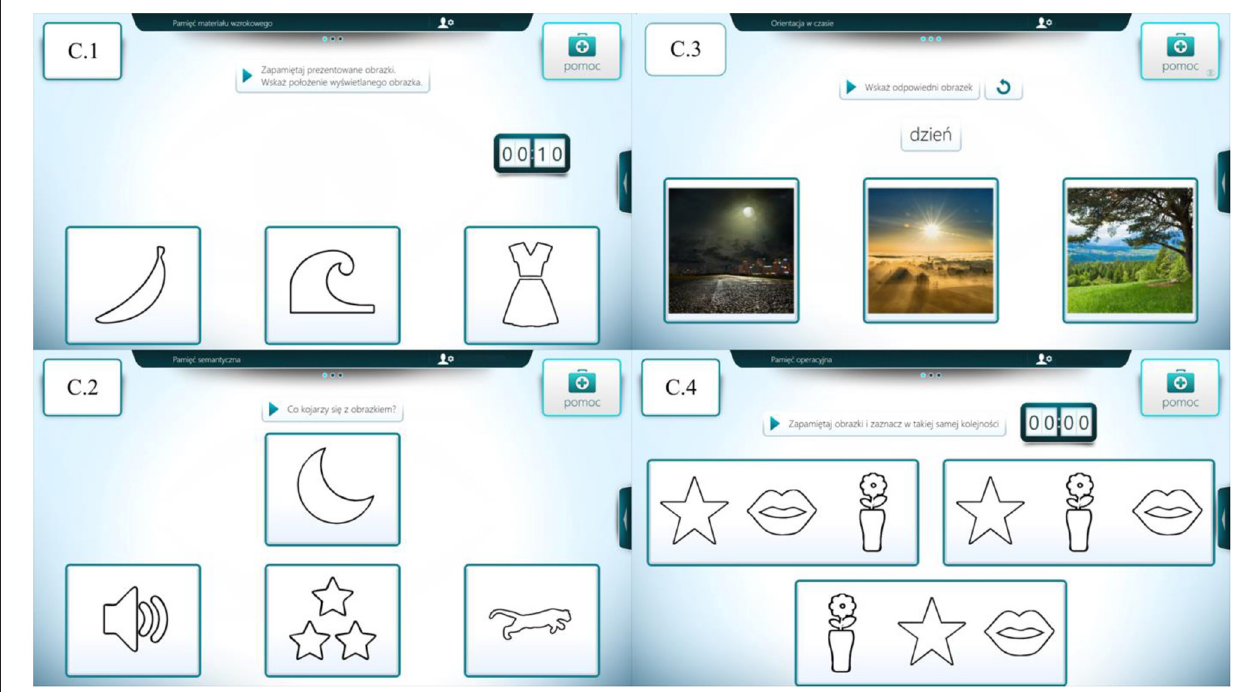
FIGURE 1 | Graphical representation of the four task categories. Own source: C.1—memory of visual material, C.2—semantic memory, C.3—orientation to time, and C.4—working memory.